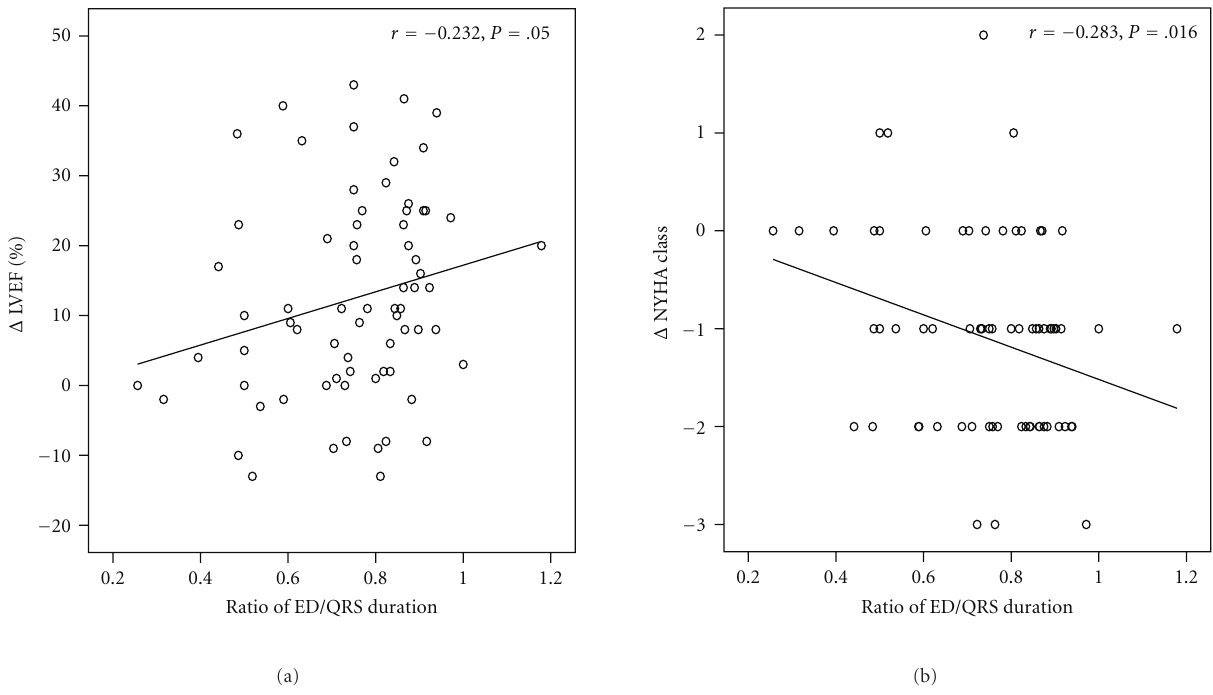
Figure 3: Correlation between ratio of ED/QRS duration and Δ LVEF (a) and Δ NYHA class (b). Abbreviations: ED: electrical delay, Δ LVEF: change in LVEF from baseline to long-term followup, Δ NYHA: change in NYHA class from baseline to long-term